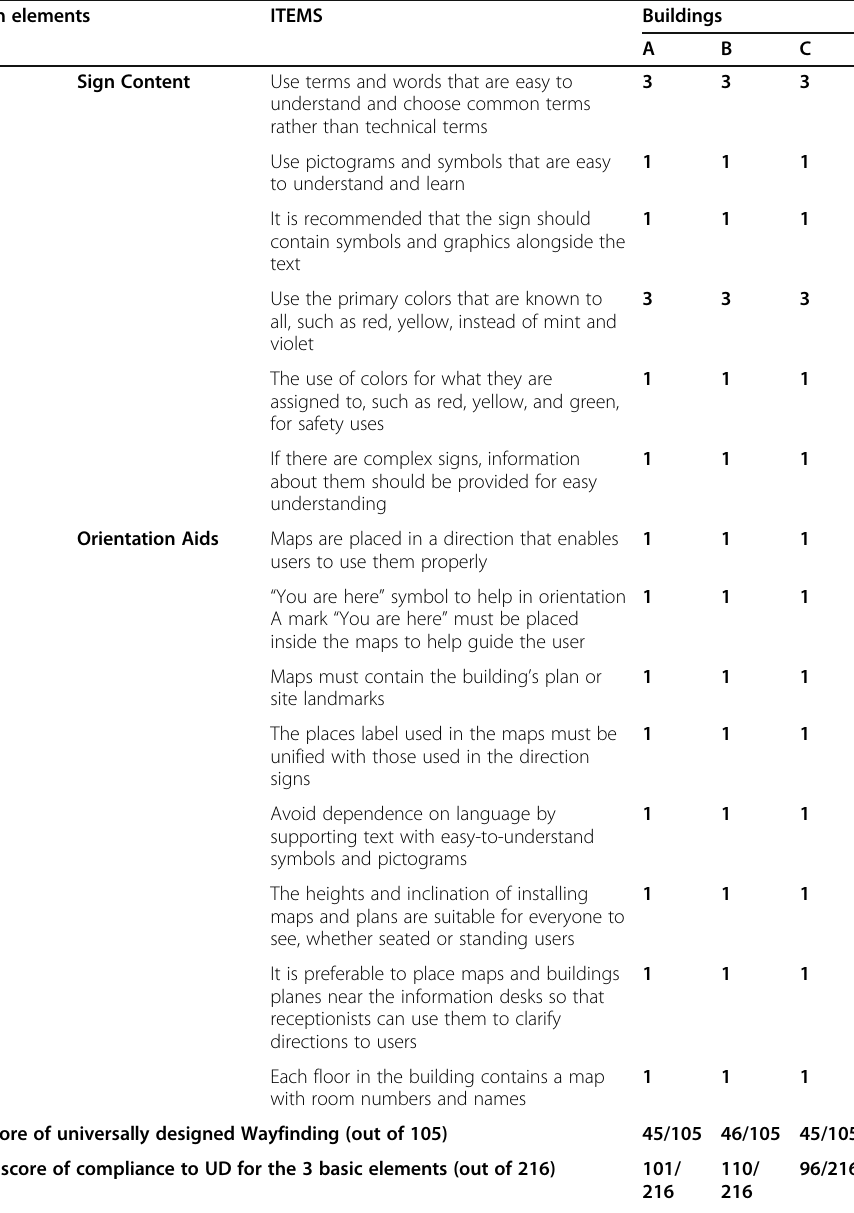
Table 3 The score of compliance to UD for each element and item in the three buildings (Continued) Main